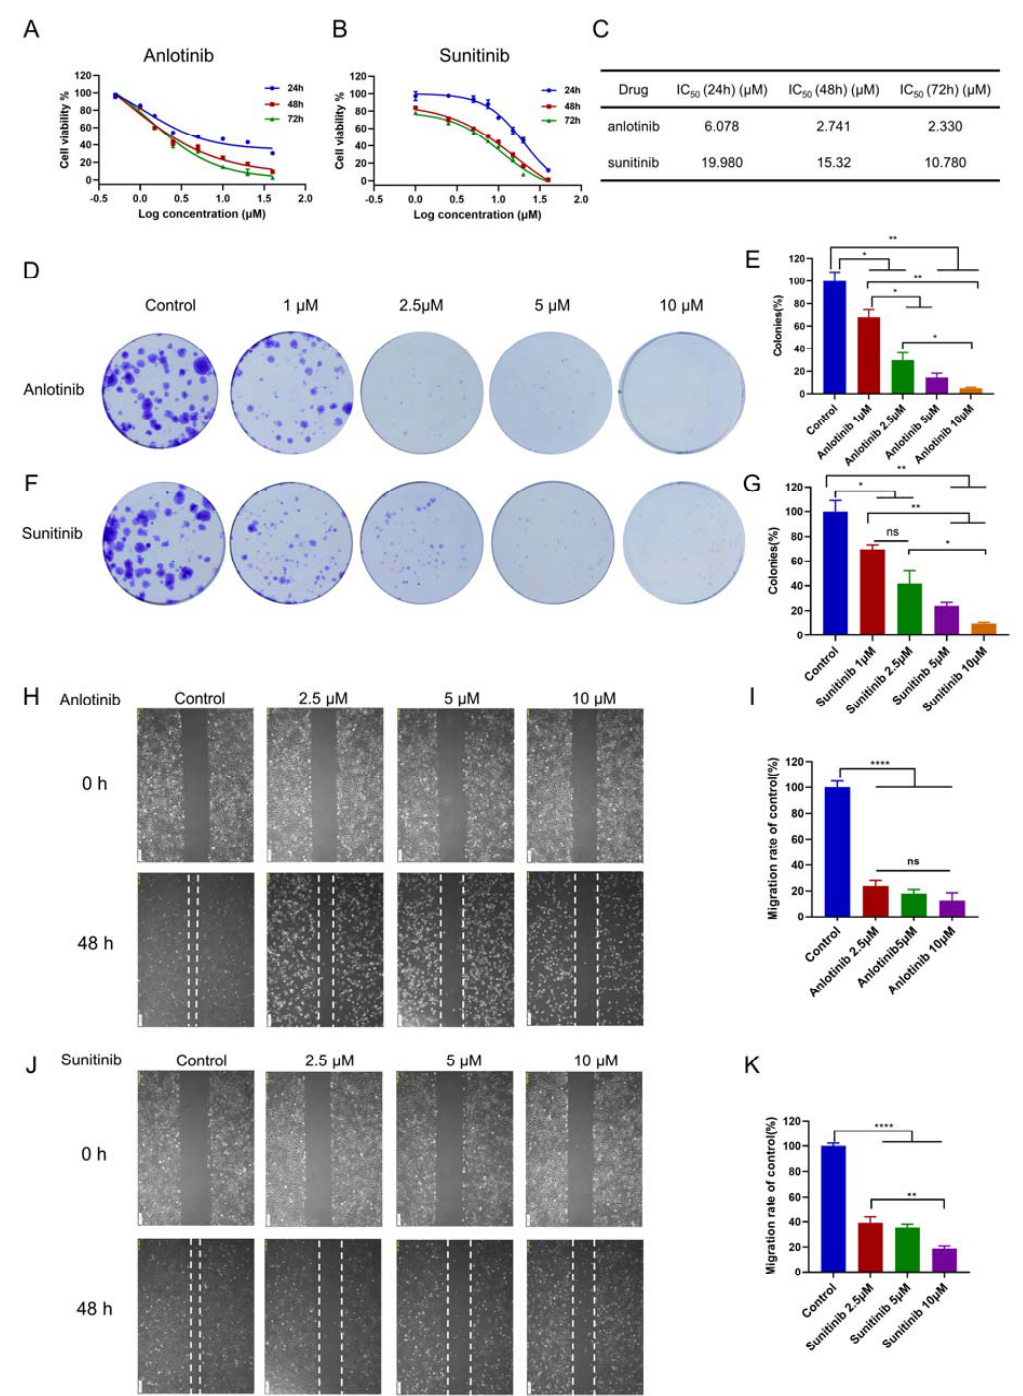
Figure 1. Anlotinib inhibited proliferation and migration of ovarian cancer cells. SKOV-3 cells were treated with anlotinib ( A ) or sunitinib ( B ) for 24, 48, or 72 h. CCK-8 assay was used to measure the viability of ovarian cancer cells, and IC 50 values were calculated ( C ). ( D , F ) Representative images of colony formation assay. ( E , G ) The inhibition degrees of colony formation are shown in the histograms. Representative images of anlotinib ( H ) and sunitinib ( J ) inhibited SKOV-3 cells migration in wound- healing assay. ( I , K ) The degrees to which the wounds healed in the indicated groups are shown in the histograms. The data are presented as the mean ± SD from three independent experiments. * p < 0.05; ** p < 0.01; **** p < 0.0001; ns,